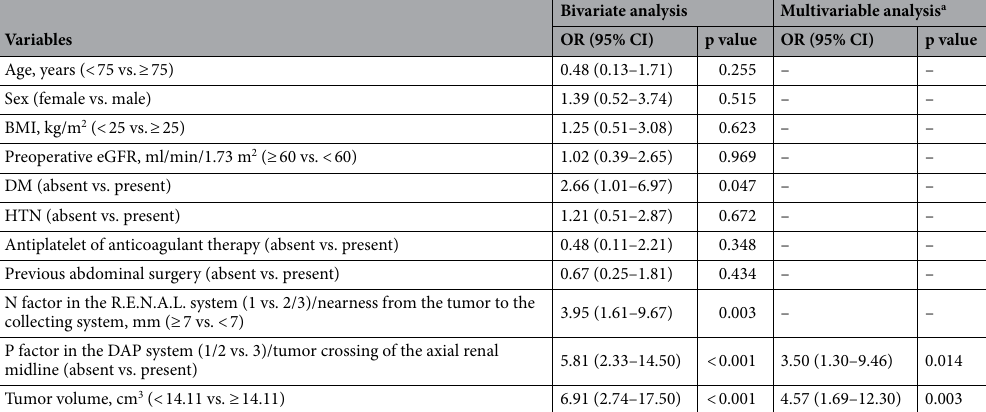
Table 4. Bivariate and multivariable analyses of preoperative clinical factors for predicting postoperative eGFR reduction. BMI body mass index; eGFR estimated glomerular filtration rate; DM diabetes mellitus; HTN hypertension; R.E.N.A.L. Radius, exophytic/endophytic, nearness to collecting system or sinus, anterior/ posterior, and location relative to polar lines; DAP diameter-axial-polar; OR odds ratio; CI confidence interval. a Backward step-down selection was